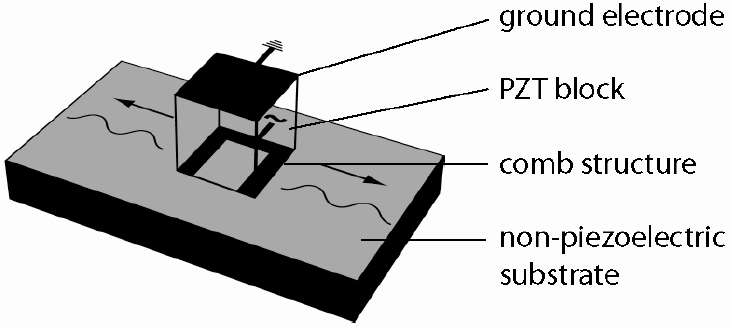
Figure 2. Single phase transducer for exciting surface acoustic waves on non-piezoelectric